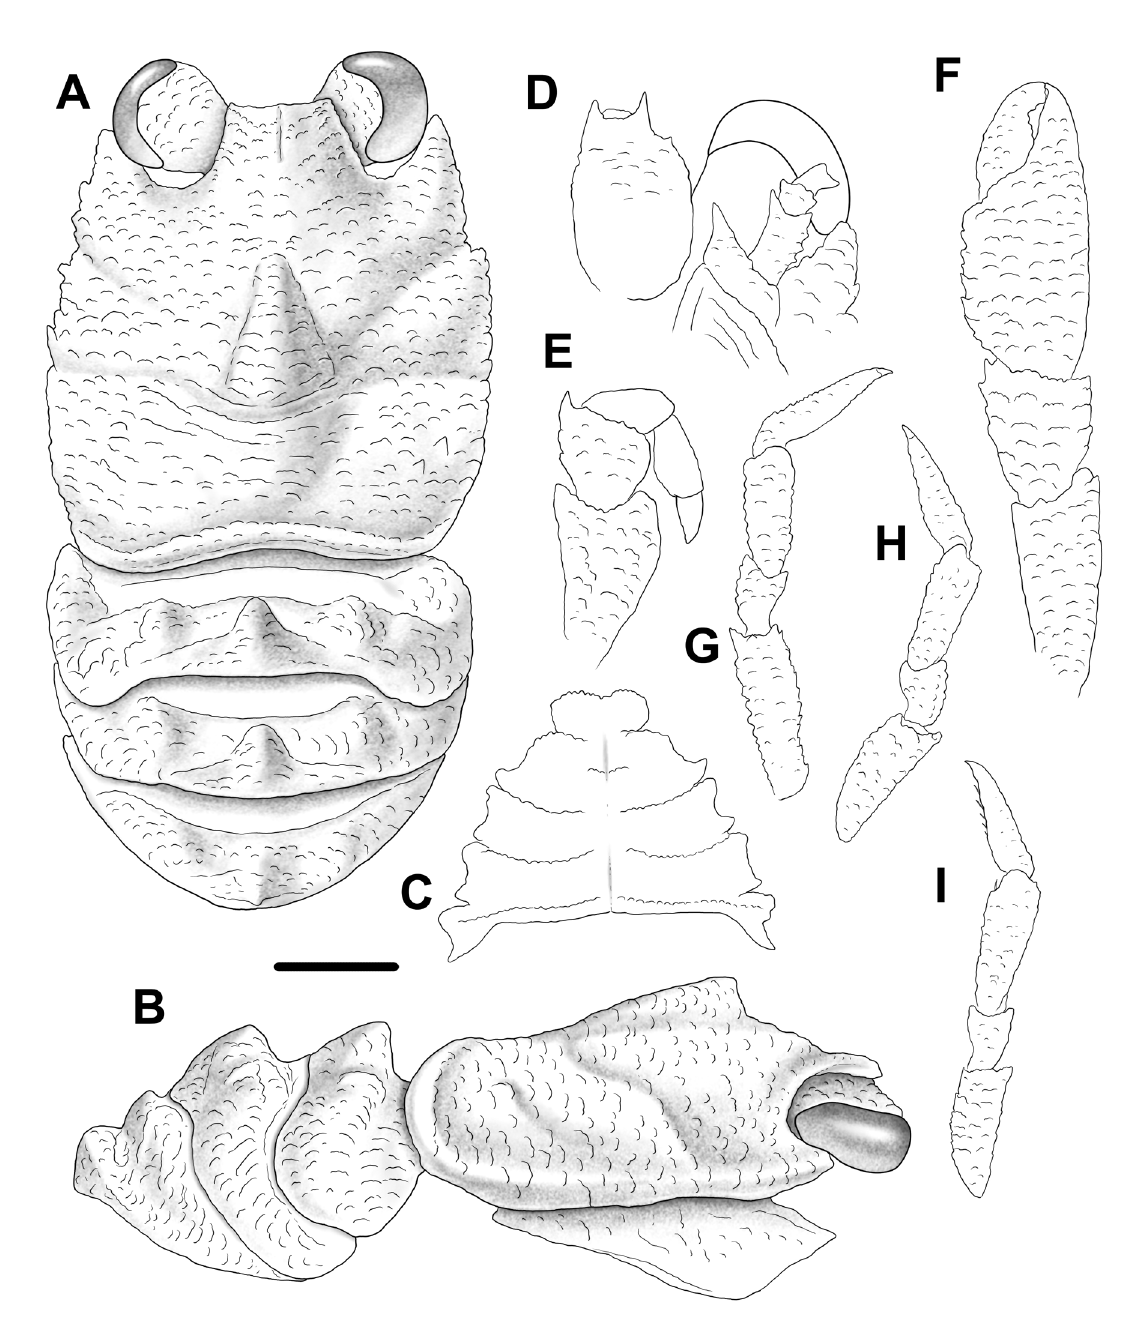
Fig. 1. Heteronida ceres sp. nov., holotype, ♂, CL = 3.5 mm (MNHN-IU-2013-1847), New Caledonia. A . Carapace and abdomen, dorsal view. B . Carapace and abdomen, lateral view. C . Sternal plastron. D . Cephalic region, showing antennular and antennal peduncles, ventral view. E . Right Mxp3, lateral view. F . Right P1, dorsal view. G . Right P2, lateral view. H . Left P3, lateral view. I . Left P4, lateral view. Scale bar: A–C, F–I = 1.0 mm; D–E = 0.5